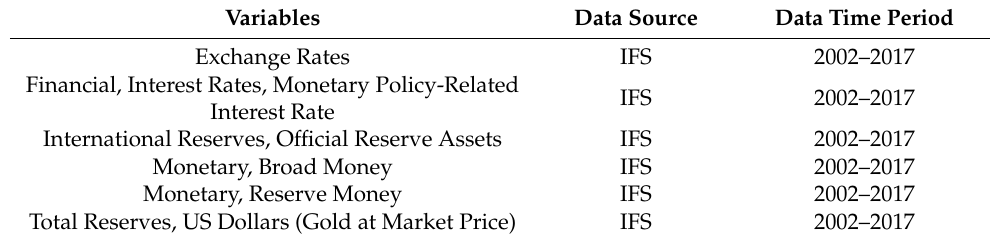
Table 1. Variables and data